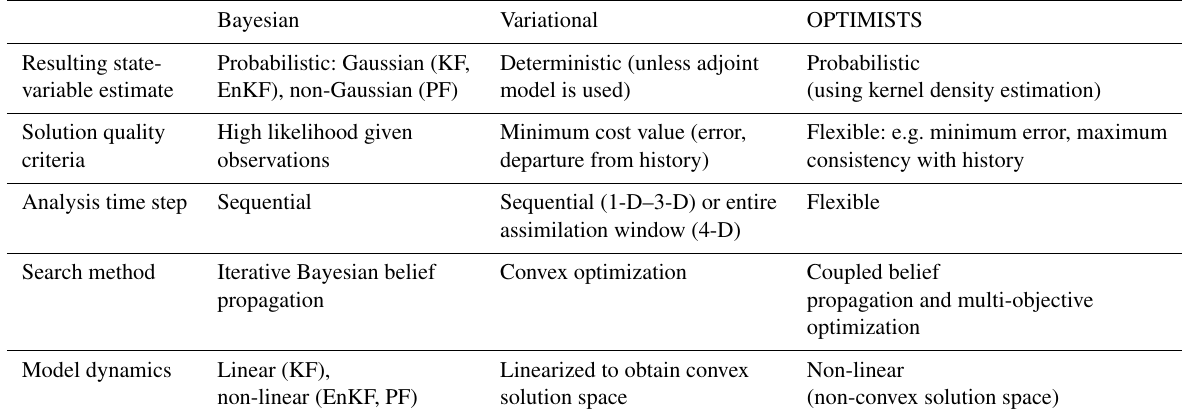
Table 1. Comparison between the main features of standard Bayesian data assimilation algorithms (KF: Kalman filter, EnKF: ensemble KF, PF: particle filter), variational data assimilation (one- to four-dimensional), and